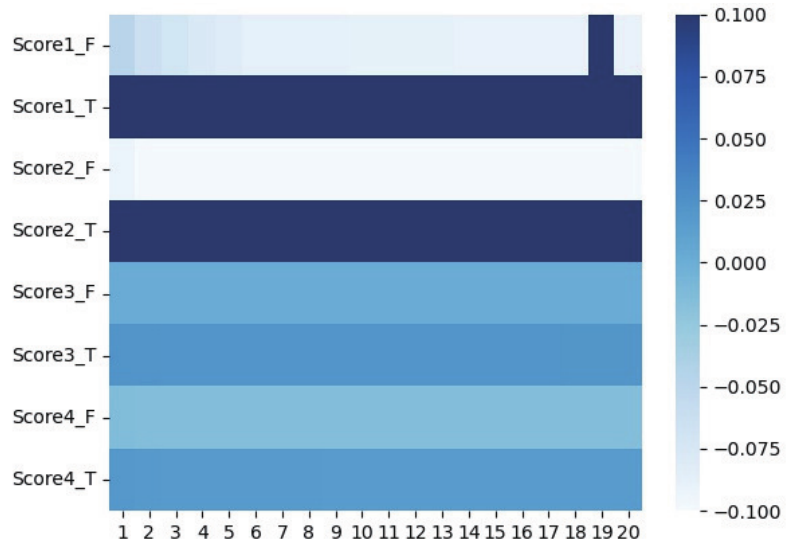
Figure 7. Heatmap for final scores to verify the effect of the type hierarchy concept modular compo- nents, and the input sentence is “the army‘s 3rd infantry division 1st marine division, leading the assault against